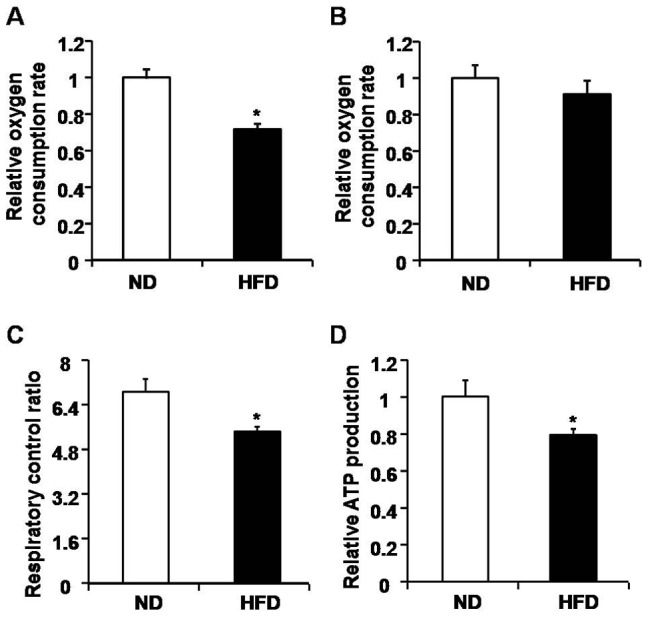
Impaired mitochondrial oxygen consumption and ATP production in skeletal muscle of HFD-induced obese mice.A and B, Relative oxygen consumption rate of state IV (B) and state III (A) in isolated mitochondria challenged by glutamate/malate and ADP. The rates in normal diet (ND) group was normalized to 1.00. n = 6 mice for each group. C, Respiratory control ratios (ratio of oxygen consumption rate of state III/state IV) in ND and HFD-induced mice. n = 10 mice for each group. D, Relative cellular ATP content in skeletal muscle from ND and HFD-induced mice. The ATP content in ND group was normalized to 1.00. n = 9 mice for each group. *, P<0.05 compared to ND.